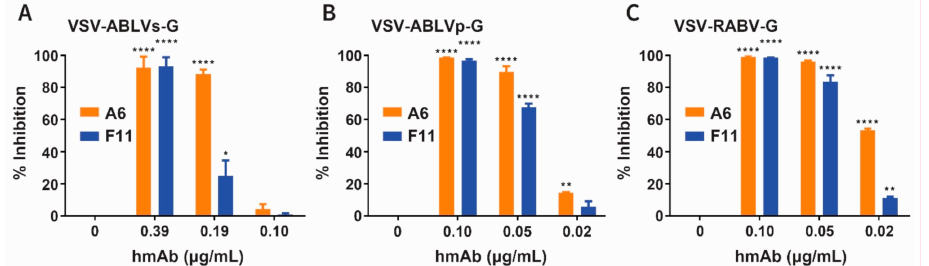
Figure 4. Inhibitory activity of anti-ABLVs G hmAbs A6 and F11 against rVSV-ABLV-G and rVSV- RABV-G infections. HEK239T cells infected with replication-competent recombinant rVSV-GFP viruses expressing ( A ) ABLVs G, ( B ) ABLVp G, and ( C ) RABV G were treated with hmAbs A6 (orange) or F11 (blue). The subsequent percent (%) inhibition was calculated as described in Section 2. Error bars represent the standard error of the mean (SEM); * p = 0.05, ** p = 0.01, **** p < 0.0001, determined by two-way ANOVA with multiple comparisons.